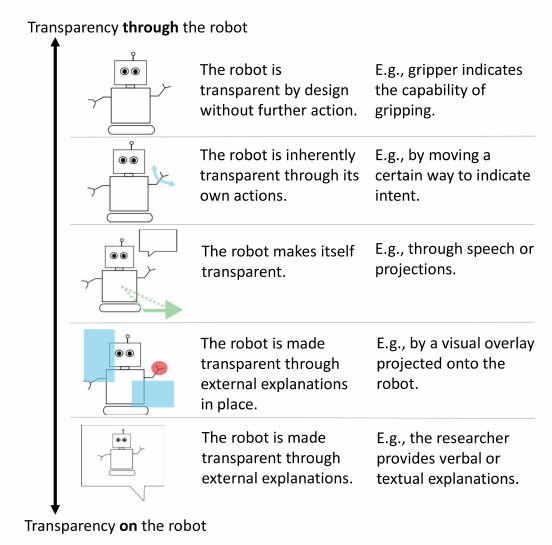
Figure 2. Classification of robot transparency by integration. On the top, transparency is realized through the robot itself, while on the bottom, the transparency is realized from the outside on top of the